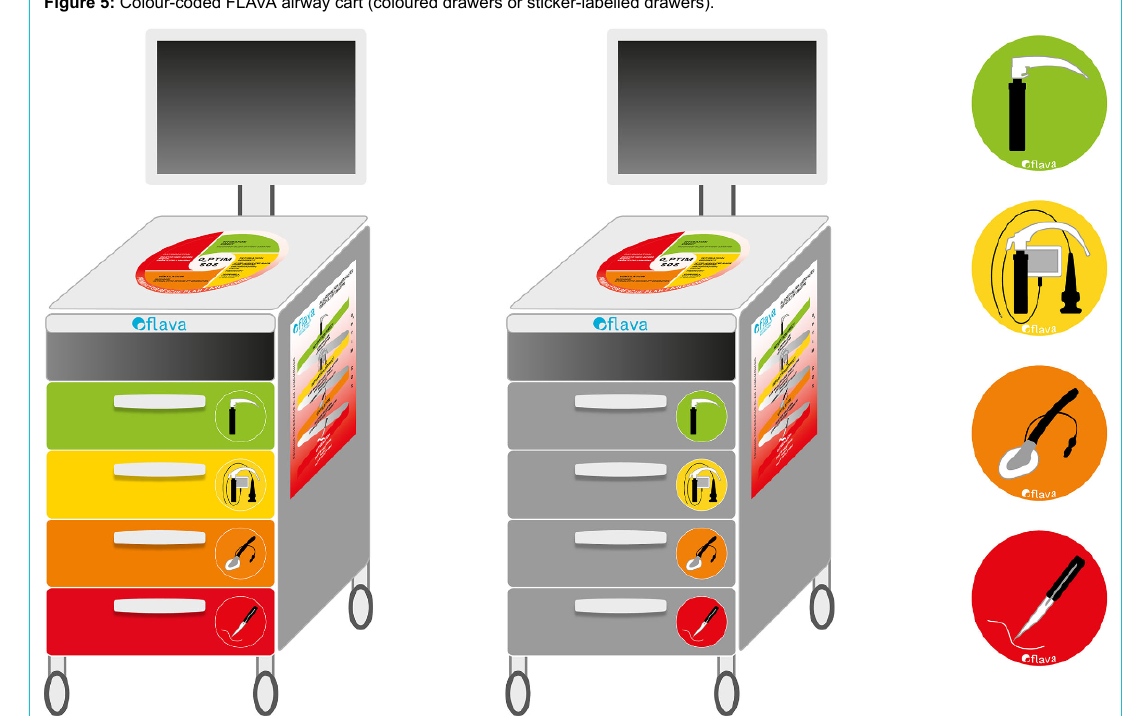
Figure 5: Colour-coded FLAVA airway cart (coloured drawers or sticker-labelled